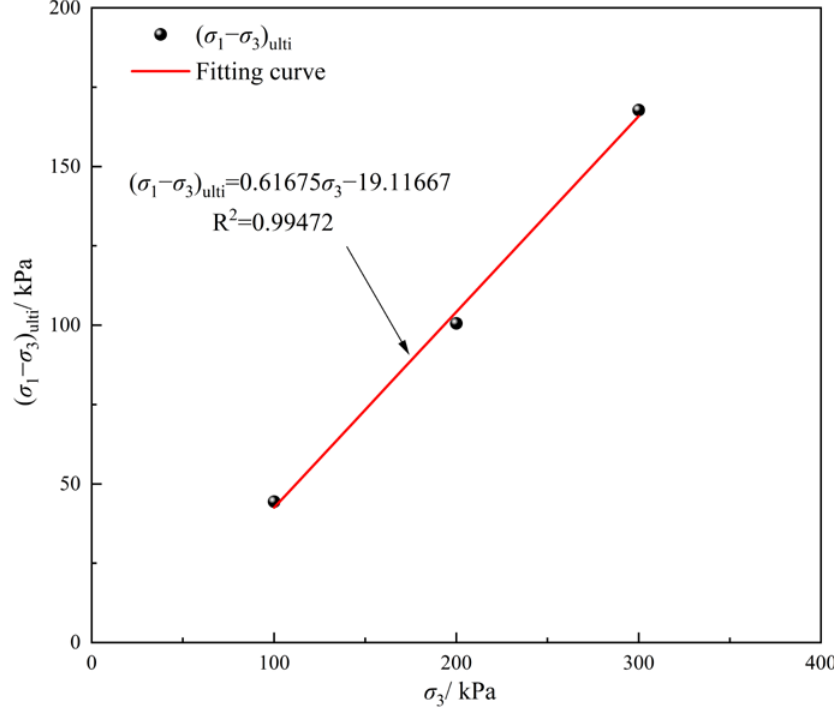
Figure 11. Relationship between ( σ 1 − σ 3 ) ulti and σ 3.